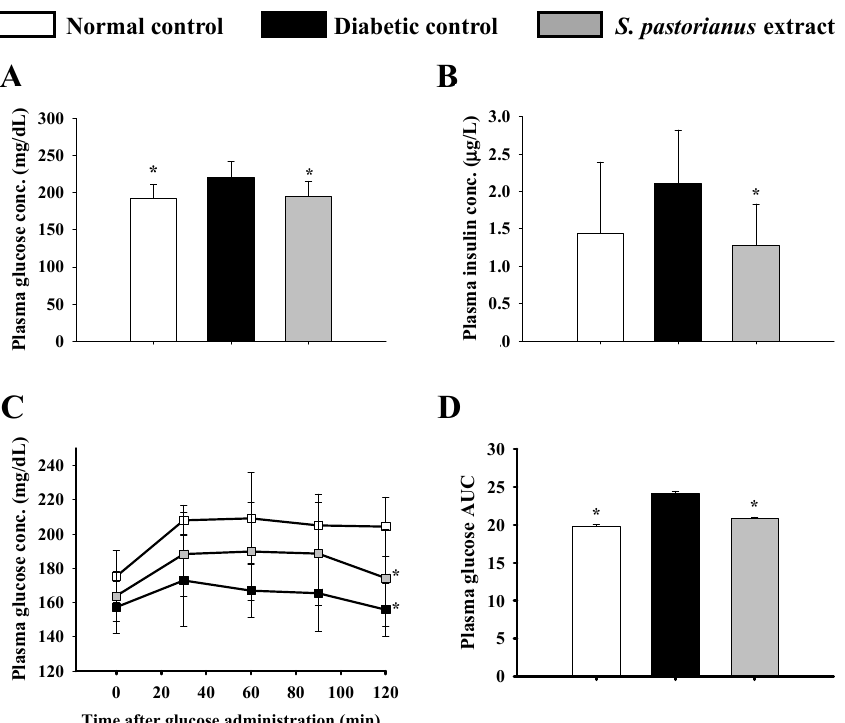
Figure 2. The level of plasma glucose in rats treated with S. pastorianus extract. The rats were injected with nicotinamide and streptozotocin for the induction of diabetes and fed with S. pastorianus extract for 6 weeks as described in Materials and Methods. After fasting for 12 h, the blood samples were collected for the determination of fasting plasma level of ( A ) glucose and ( B ) insulin. After oral administration of glucose, the blood samples were collected at 0, 30, 60, and 120 min for the determination of ( C ) plasma glucose and ( D ) the area under the curve (AUC) of plasma glucose concentration. Results are expressed as mean ± SD for each group of rats ( n = 8). * p < 0.05 compared with diabetic control.